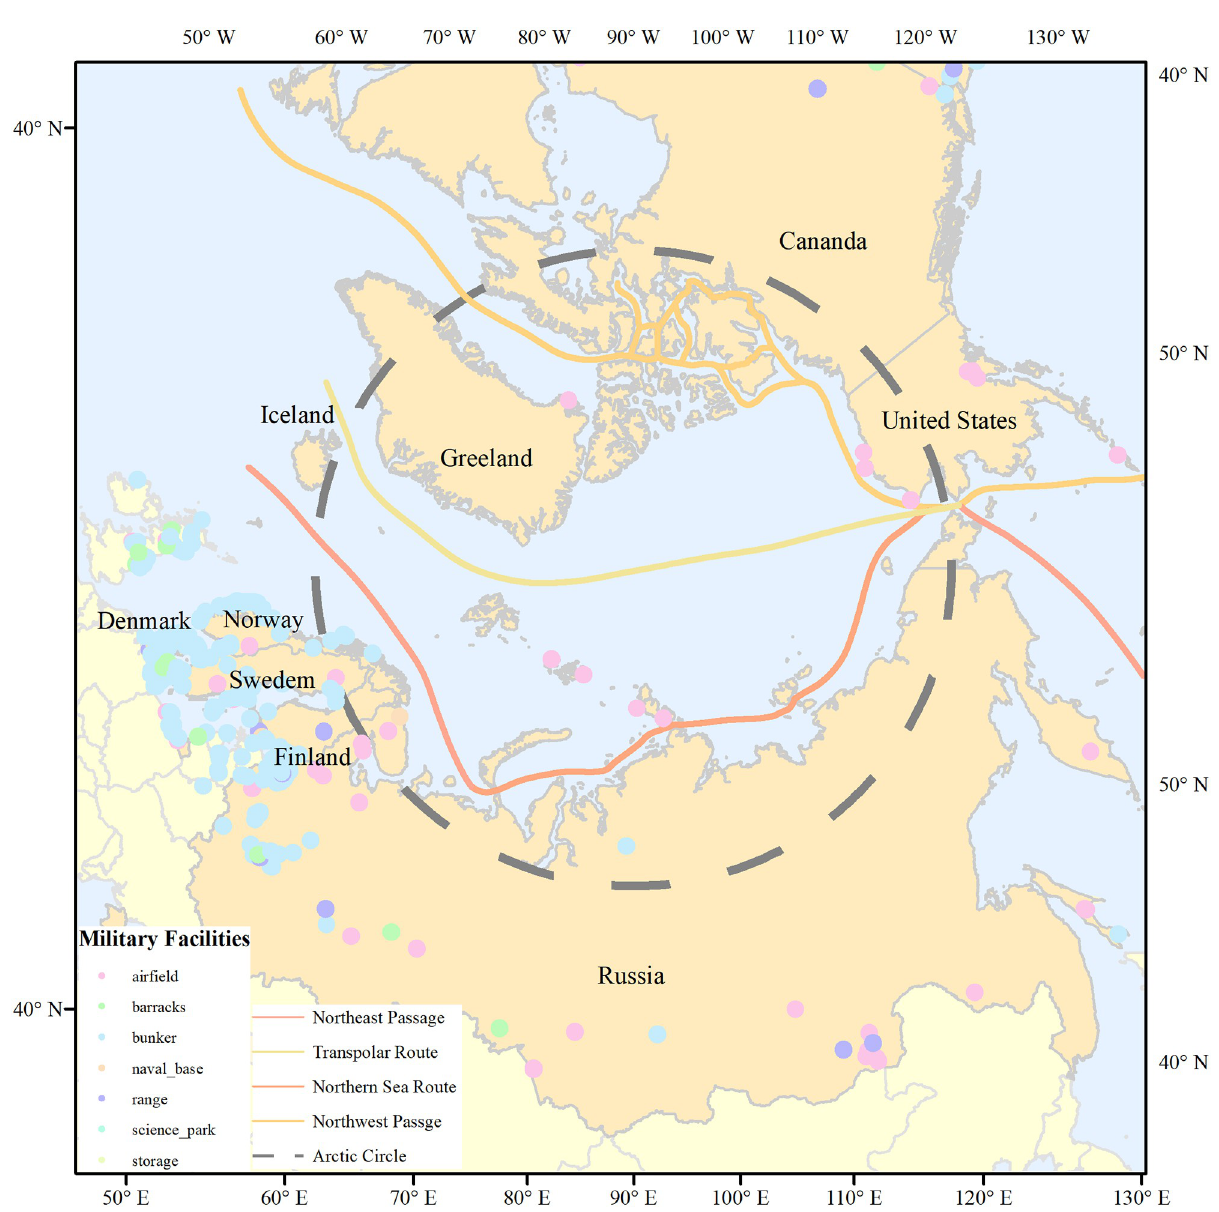
Fig 5. Example of the point of geo-military characteristic spatial match. The boundary was obtained from Natural Earth (http://www. naturalearthdata.com/).